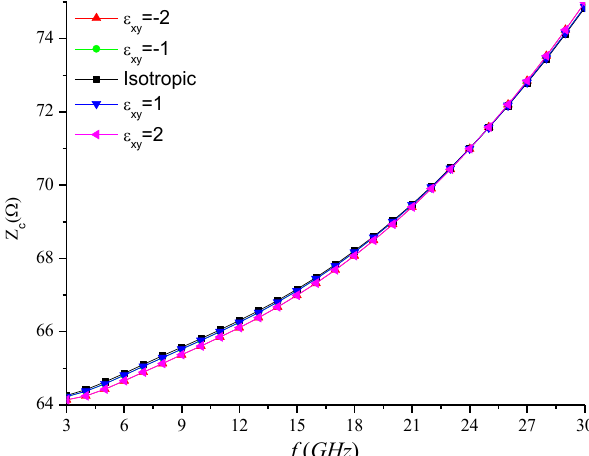
Figure 5.b: Effect of real valued e xy on the characteristic